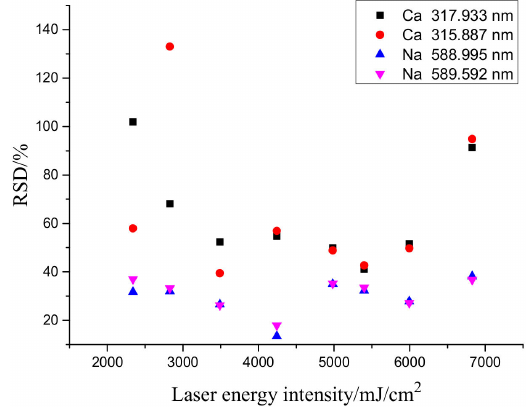
Figure 6. Relationship between the relative spectral intensity and measurement repeatability of the elements